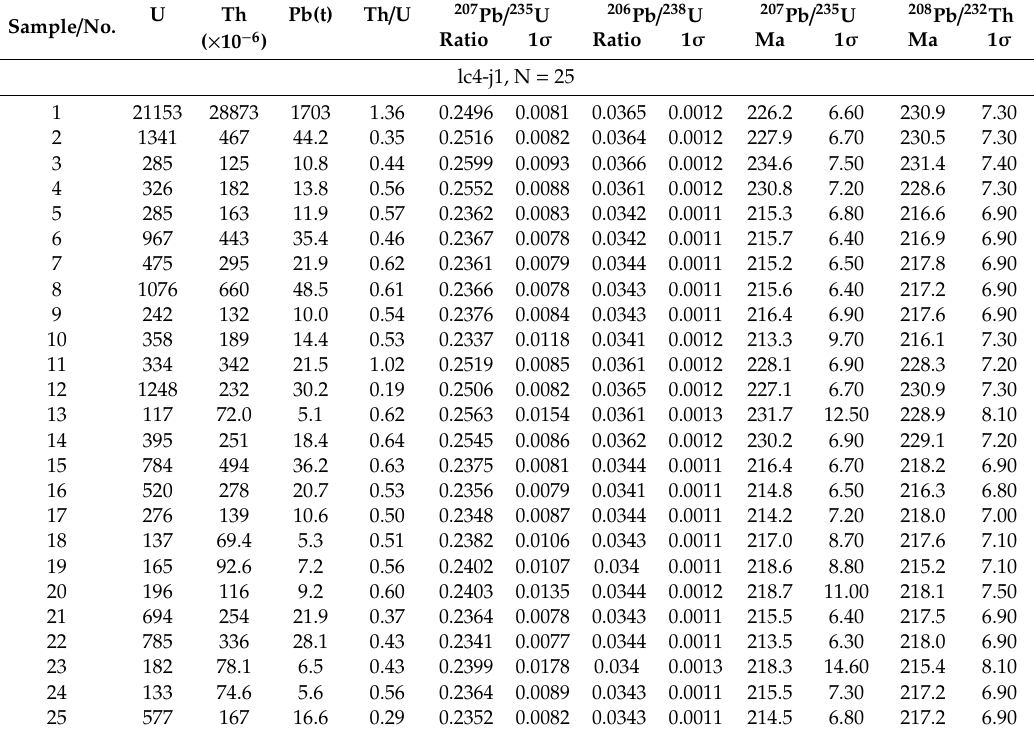
Table 3. LA-ICP-MS zircon U-Pb analytical data of the QN and MH granites. Sample /